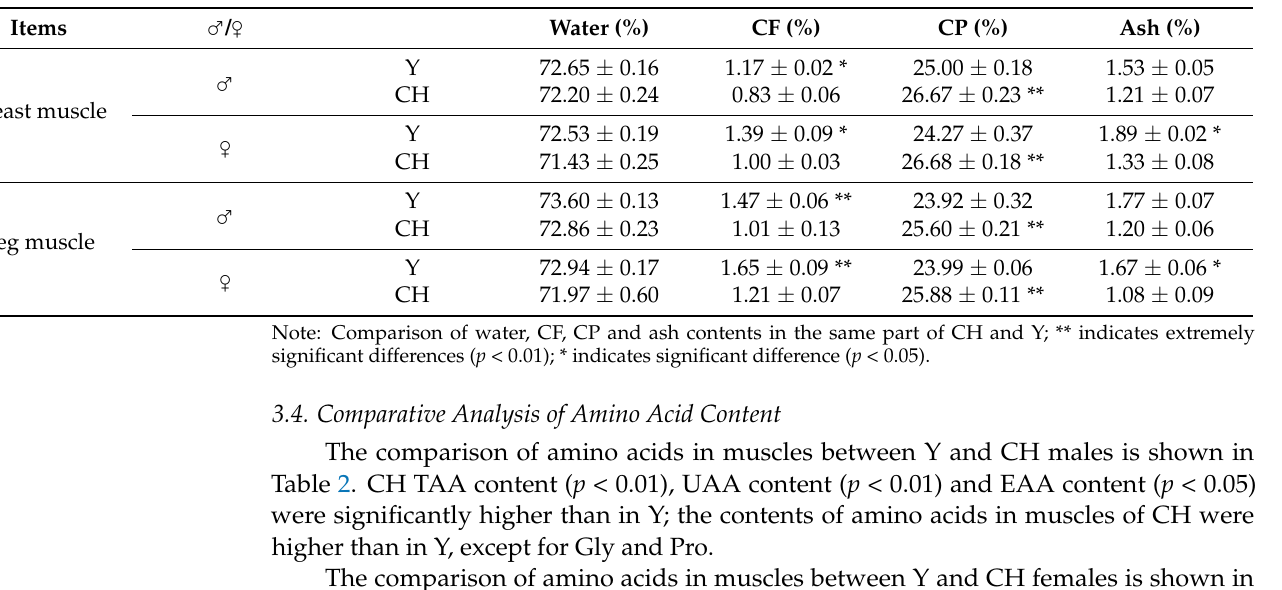
Table 1. Chemical composition of muscle of two chicken